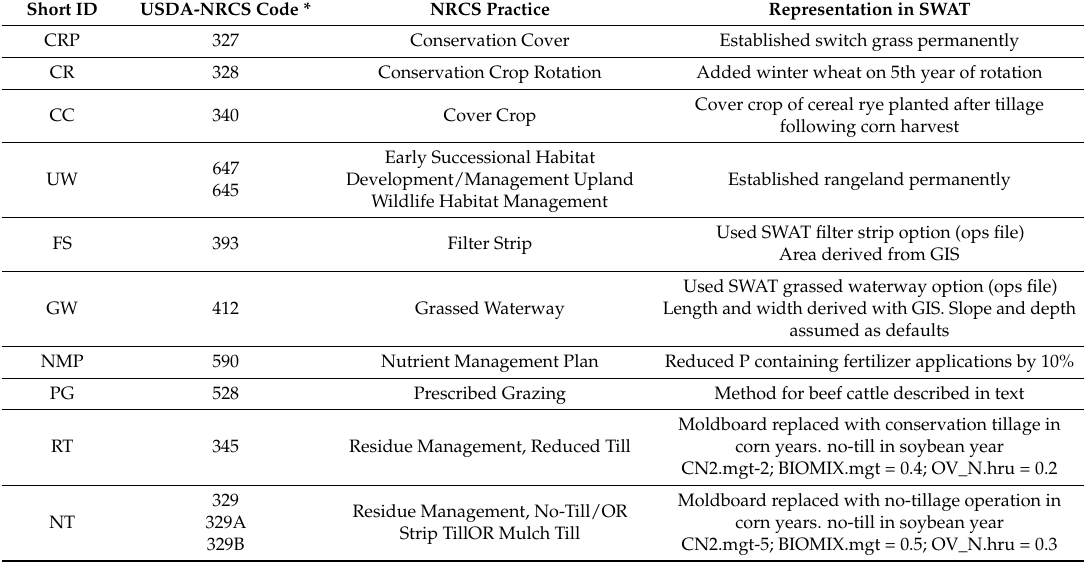
Table 3. Best management practices in Eagle Creek watershed, Ohio and representation in